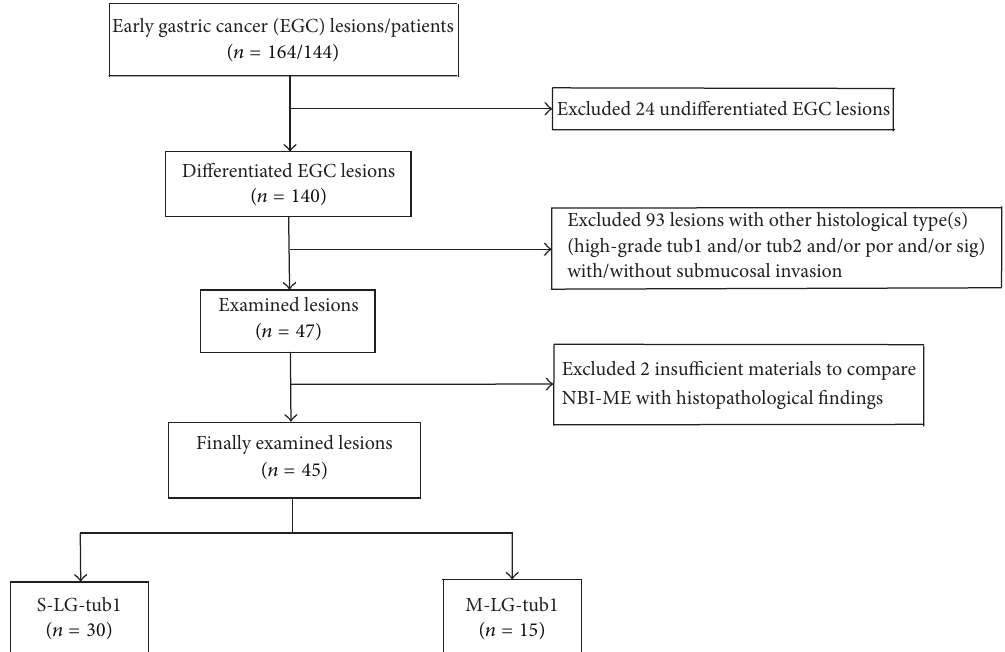
Figure 1: The investigation flow. Firstly, twenty-four undifferentiated early gastric cancer (EGC) lesions were excluded. Secondly, ninety- three lesions were excluded because they were composed of different histological types from low-grade- (LG-), well-differentiated tubular adenocarcinoma (tub1) (LG-tub1) with or without submucosal (SM) invasion. Thirdly, two lesions were excluded because of heat-induced degeneration during endoscopic submucosal dissection (ESD) and hence an insufficient amount of material for making comparisons. Finally, we were able to perform detailed comparisons of magnifying endoscopy with narrow-band imaging (NBI-ME) and post-ESD histological findings for 30 simple-type- (S-) LG-tub1 (S-LG-tub1) and 15 mixed-type- (M-) LG-tub1 (M-LG-tub1)